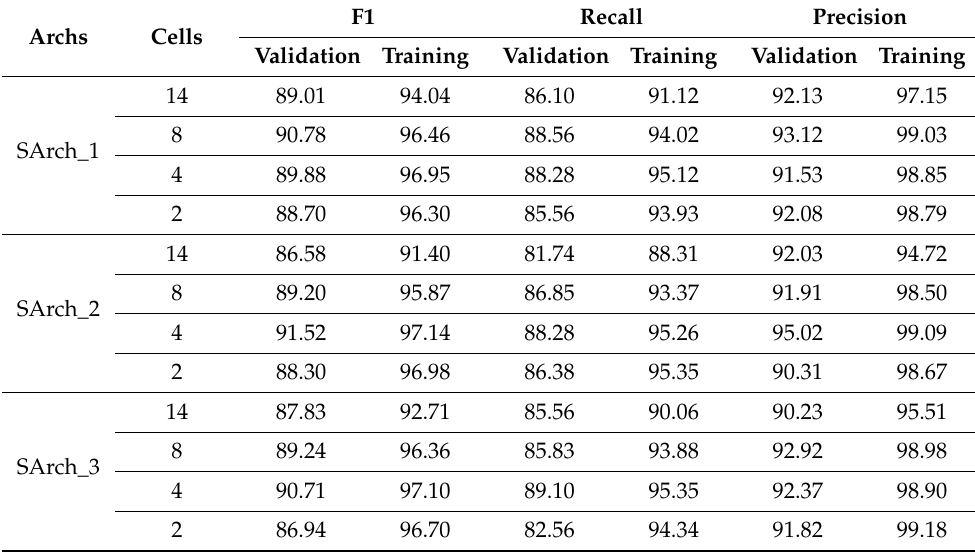
Table 4. Detection results on SSDD after reducing the number of cells. F1 Recall Precision Archs Cells Validation Training Validation